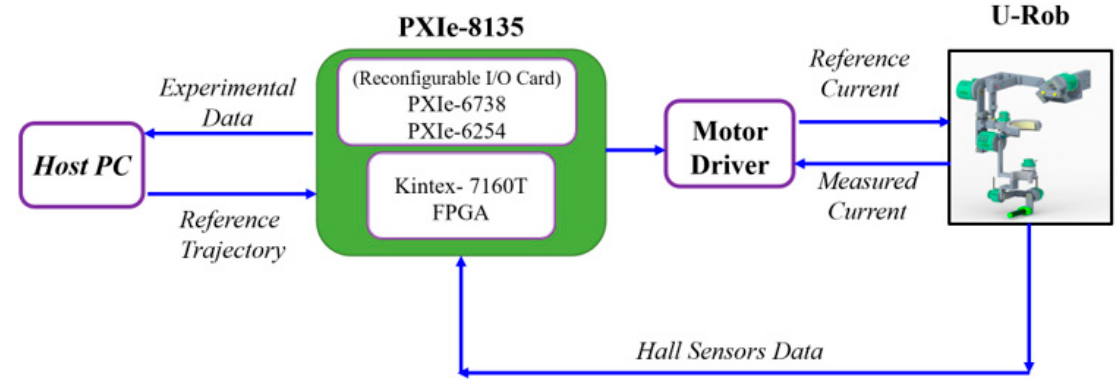
Figure 15. Schematic of control setup of u-Rob for the ( a ) exoskeleton setup and ( b ) end-effector setup.